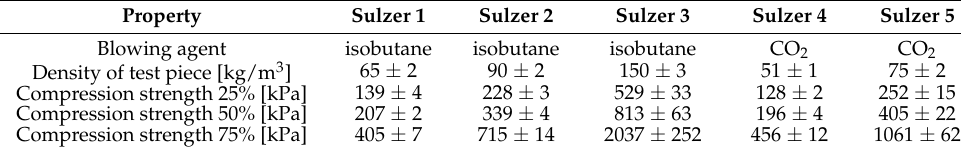
Table 3. Compression test mechanical properties of the